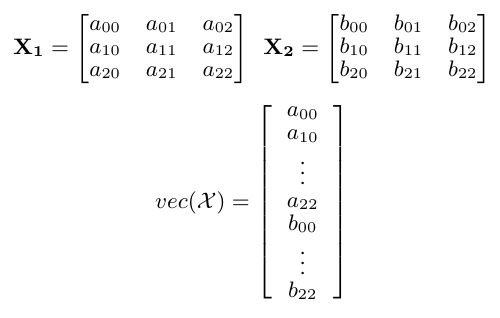
Figure 3. Vectorization of a tensor X ∈ R 2 × 3 × 3 with 2 frontal slice X 1 and X 2